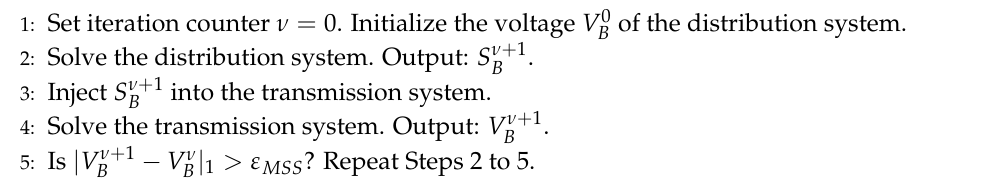
Algorithm 1 The Master-Slave Splitting Iterative